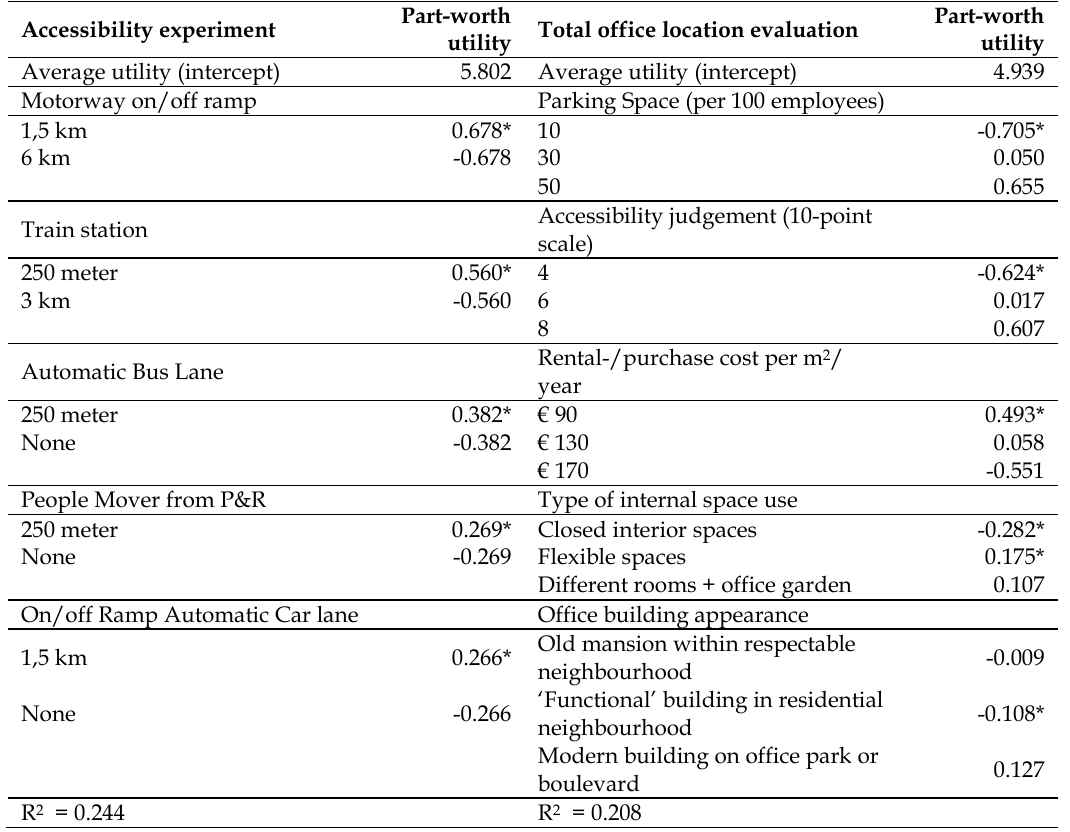
Table 1. Estimated parameters for HII model